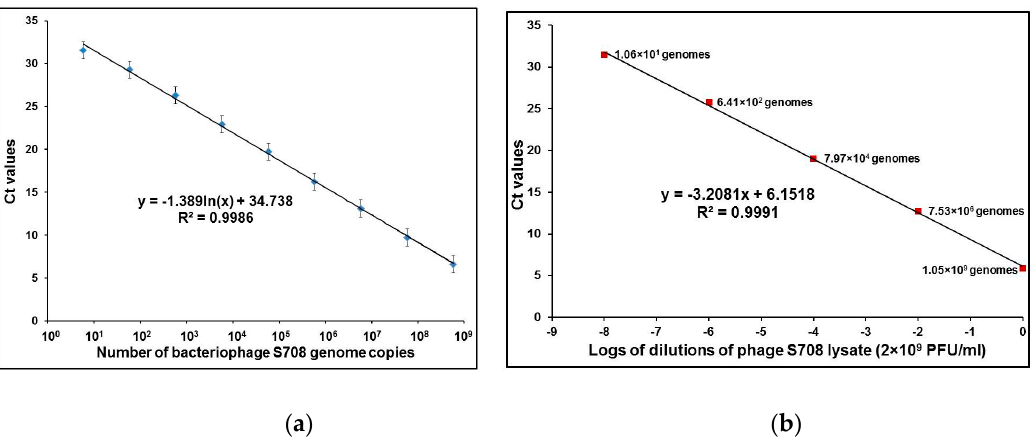
Figure 1. qPCR of purified DNA of brucellaphage S708 ( a ) and S708 lysate ( b ). Calibration curve ( a ) was established using qPCR of 1 µL aliquots of nine different 10-fold dilutions of purified DNA from brucellaphage S708, ranging from 0.35 fg to 3.5 ng. Calibration curve ( b ) was established using qPCR of 1 µL aliquots of several 100-fold dilutions of phage S708 lysate, ranging from ~10 0 to ~10 8 PFU. The number of viable particles per sample was confirmed by plaque assays Ct: cycle threshold.